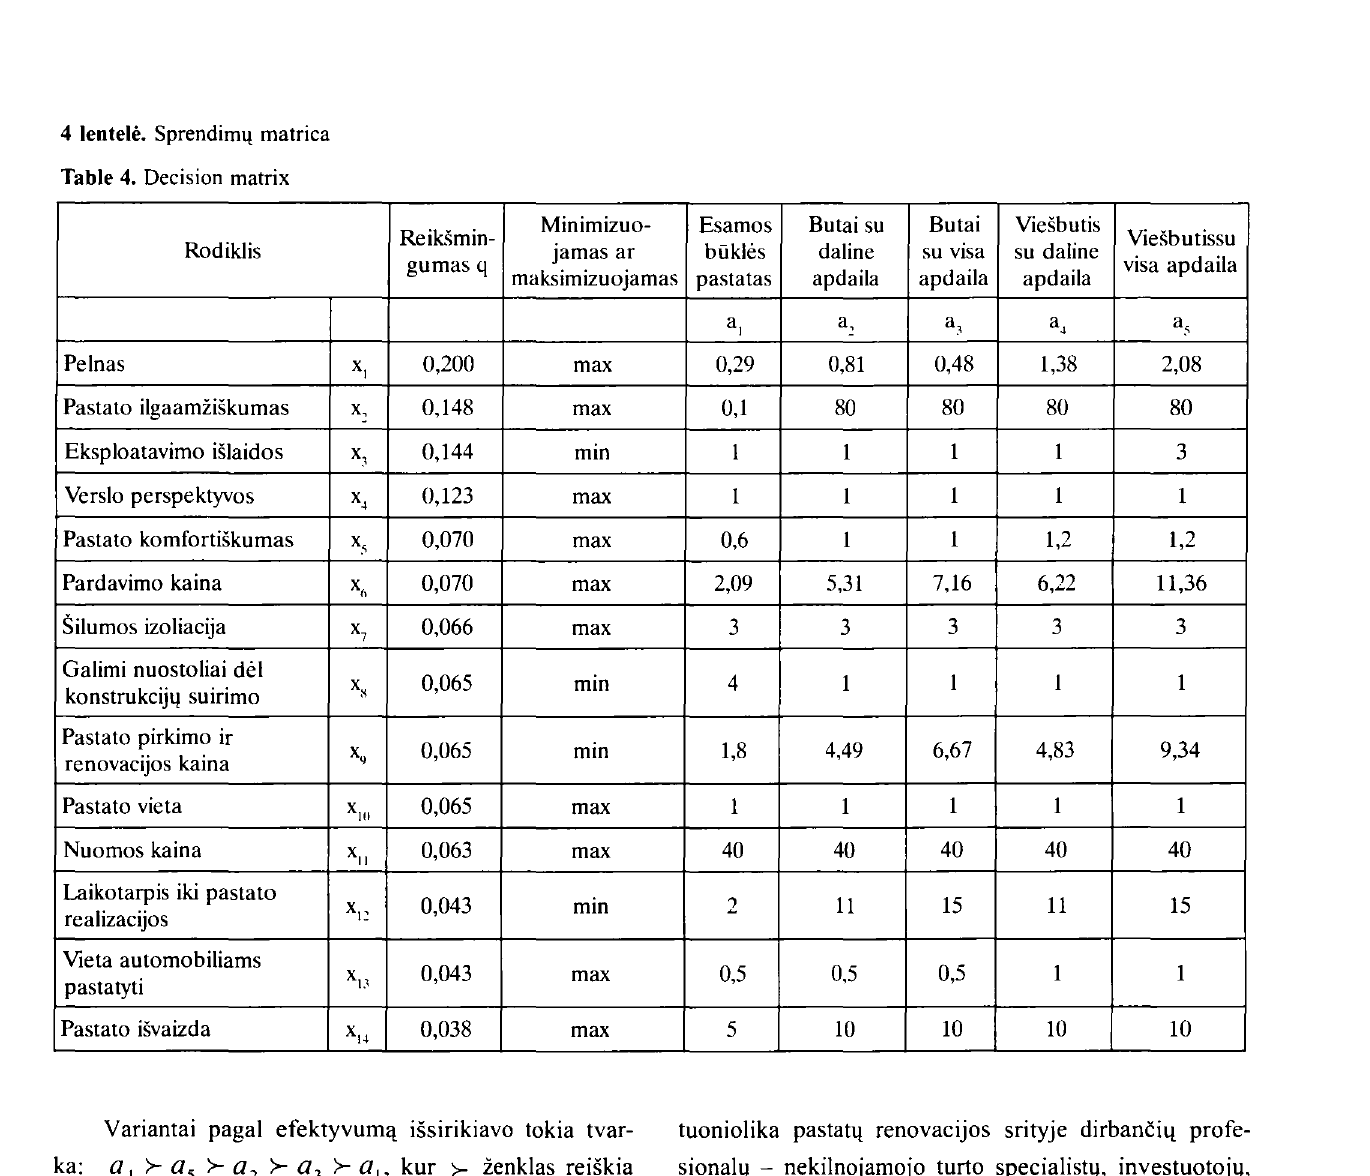
Table 4. Decision matrix